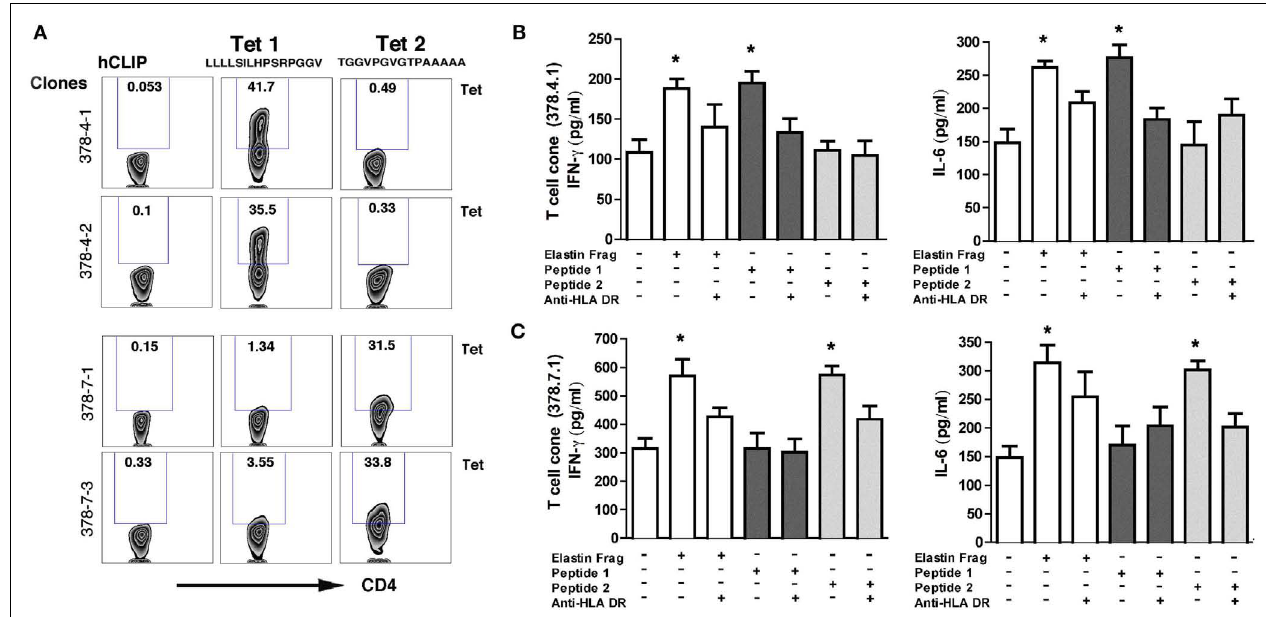
above each of the gated area in the plots. Data are representative of three independent assays. Representative measurement of IL-6 secretion inT cell clones (B,C) in response to peptide 1 and peptide 2 (300 µ M each) as described in experimental condition above (A) . Data are mean ± s.e.m. of three measurements, represents one of six independent studies. ∗ P < 0.05; determined by the Student’s t -test comparing to the baselineT cell cytokine